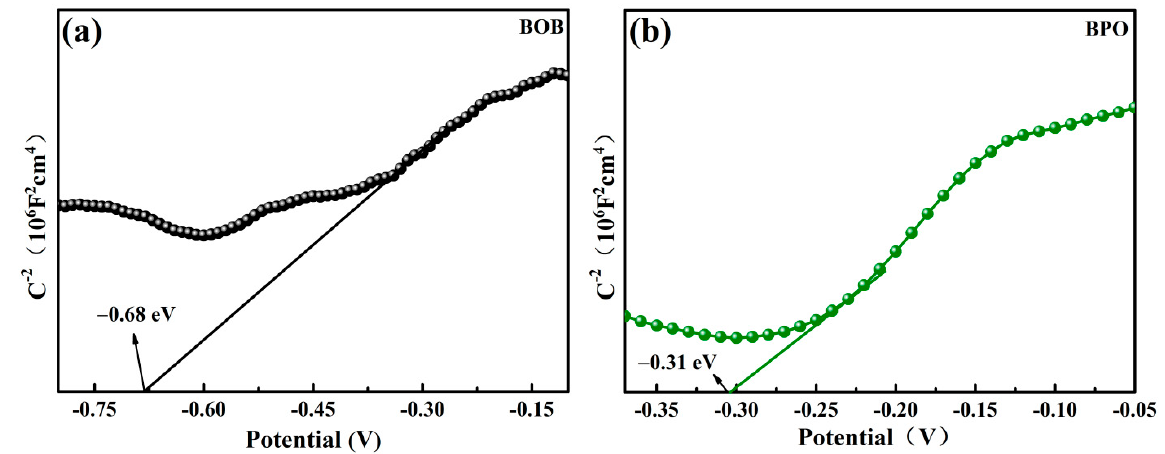
Figure 6. Mott-Schottky plots of BOB ( a ) and BPO ( b ). The schematic diagram of the band-structure-based photocatalysis mechanism by the PBX series is preliminarily conjectured in Figure 7. Upon visible light irradiation, BOB is able to be excited to generate charge carriers after absorbing photons with sufficient en- ergy in the left of Figure 7. Electrons move to the conduction band (CB), and holes stay in the valence band (VB). Electrons in the CB tend to react with adsorbed oxygen molecules to produce radicals ·O 2 − because of the more negative E CB potential ( − 0.64 V) than the standard redox potential (O 2 /·O 2 − , − 0.046 V vs. NHE), which is in accordance with the ESR result. Holes in the VB fail to produce radicals ·OH since the standard redox potentials (OH − /·OH, 1.99 V vs. NHE, and H 2 O/·OH, 1.99 V vs. NHE) [49] are more positive than the E VB potential (1.63 V). Instead, holes together with radicals ·O 2 − can participate in the pho- tocatalytic reactions. However, the photocatalytic performance of BOB is unsatisfactory because of the serious recombination of the carriers caused by the intrinsic nature of sin- gle-phase semiconductors. Distinctly, the integration of a wide-bandgap semiconductor with a relatively positive E CB is prone to modify the carriers’ distribution by accepting photo-generated electrons. In particular, the mechanical ball milling treatment is apt to construct composites with intimate contact and efficient interfaces between different com- ponents. As shown in the right of Figure 7, BOB can be exited instead of BPO under visible light. With the assistance of BPO, electrons in the CB of BOB easily transfer to the CB of BPO through the phase interface because of the potentials’ difference, which is thermody- namically favorable. Accordingly, electrons and holes are mainly distributed in the CB of BPO and the VB of BOB, respectively. Therefore, the spatial segregation of the charge car- riers and further boosted generation of radicals ·O 2 − in the CB of BPO is achieved. As a result, the holes and produced radicals ·O 2 − in a such system favor the enhanced NO x re- moval with the avoidance of toxic NO 2 generation. On the whole, Bi 4 O 5 Br 2 -BiPO 4 compo- sites with well-matched band structures and regulated interface carriers can be used as alternative candidates for deep oxidation of NO x at the ppb level, and further decorations are still needed to further improve the photocatalytic performance and reusability in the future.